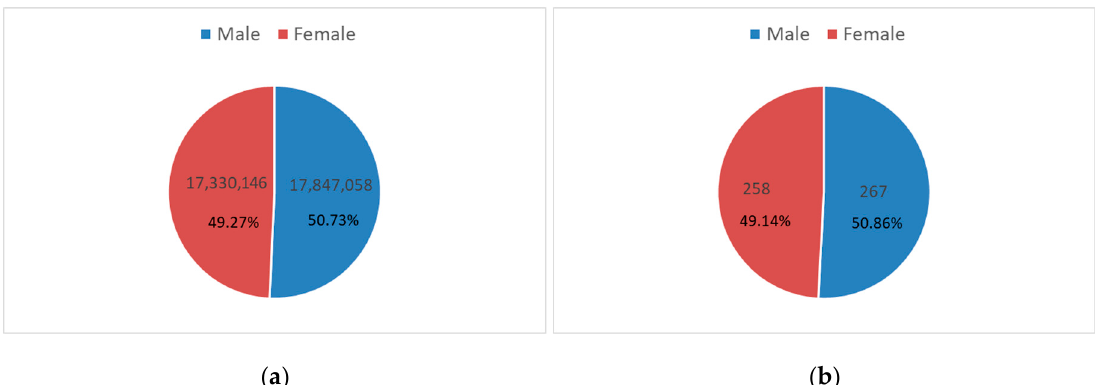
Figure A3. Comparison between research population and survey sample by gender; ( a ) Population distribution; ( b ) Sample distribution; Source: Statistic Korea [49].